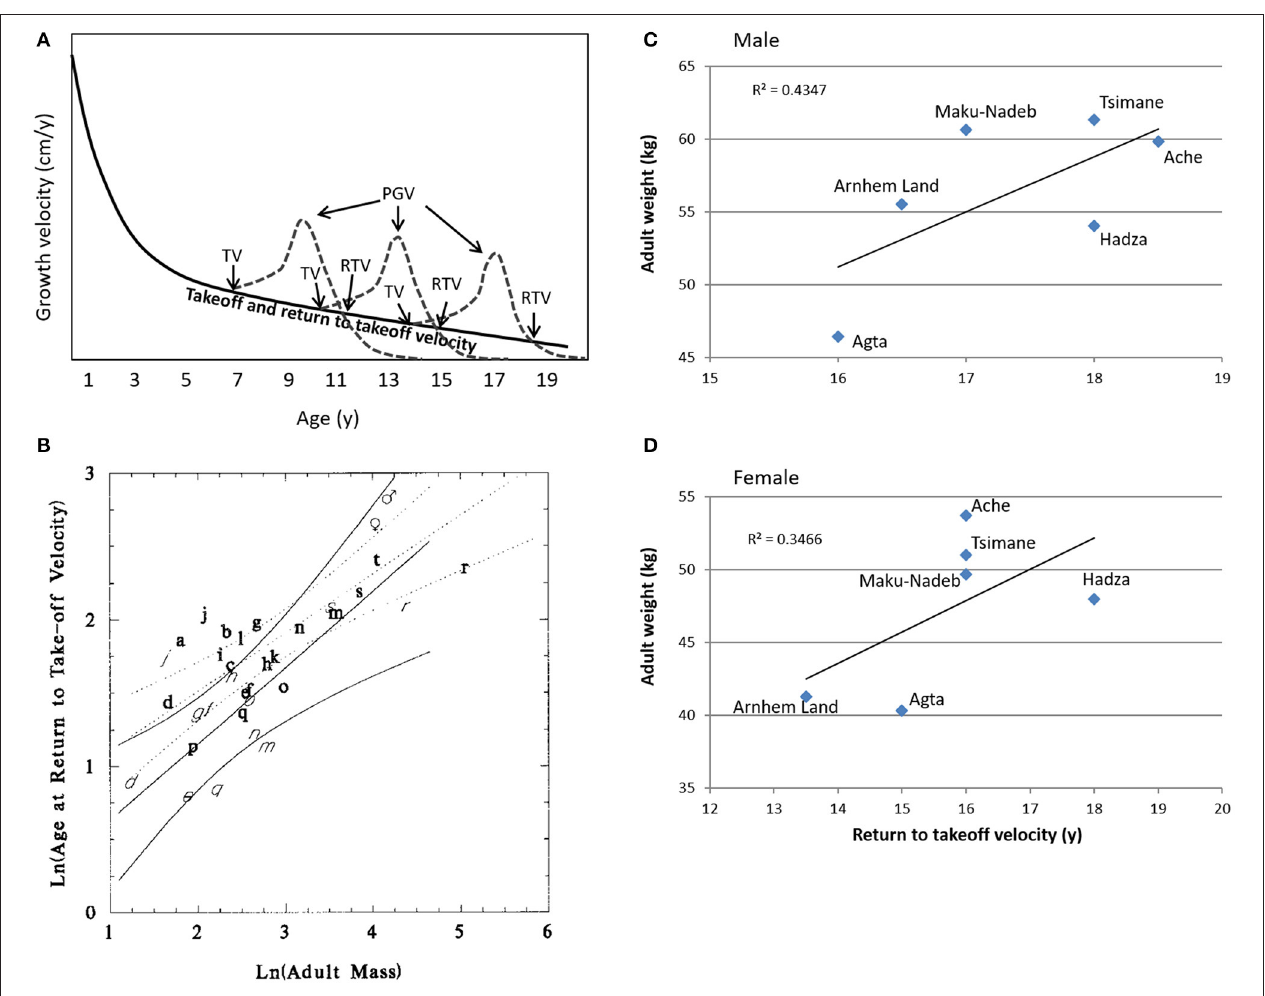
FIGURE 2 | The concept of the return to prepubertal growth velocity curve as a life history mile stone. Here, we define the return to take-off velocity as the transition from adolescence to emerging adulthood. (A) Schematic representation of the age-dependent pubertal take-off velocity and the return to prepubertal growth velocity curve; in girls the return to takeoff velocity coincides with menarcheal age in the early, average, and late maturers. The age-dependent decline in peak height velocity is a function of the decelerating takeoff velocity and returns to the prepubertal growth velocity curve. PGV, peak growth velocity; TV, takeoff velocity; RTV, return to prepubertal growth velocity curve. (B) The age of return to prepubertal growth velocity curve as a function of adult body mass in 21 primate species. Observations are derived from captive primates held at zoological parks and primate centers. With permission from Leigh and Park ( 42). a— Cebus apella , b— Cercopithecus aethiops, c— Cercopithecus mitis , d— Cercopithecus neglectus , e— Erythrocebus patas , f— Cercocebus atys , g— Macaca arctoides , h— Macaca fascicularis , i— Macaca fuscata , j— Macaca mulatta , k— Macaca nemestrina , l— Macaca silenus , m— Papio hamadryas , n— Mandrillus sphinx , o— Colobus guereza , p— Presbytis entellus